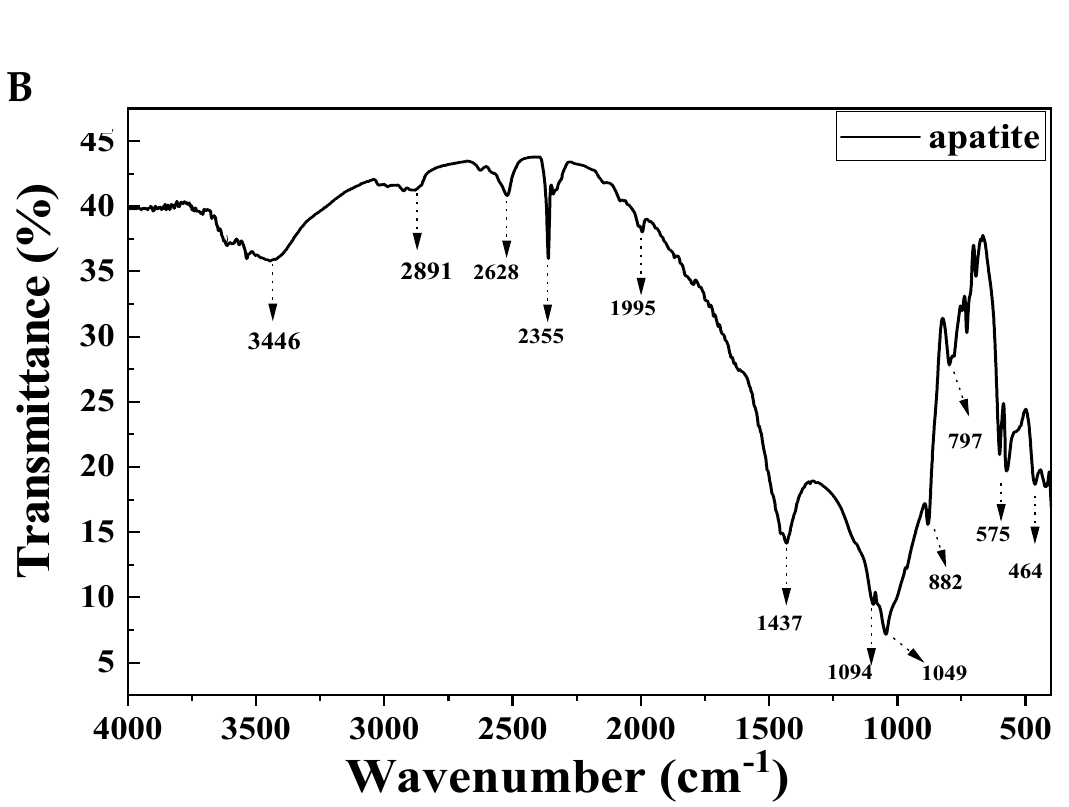
Figure 1. FTIR spectra of corn cob (CC), corn cob-derived biochar at 400 °C (CB400) and 600 °C (CB600) ( A ) and apatite ( B ).